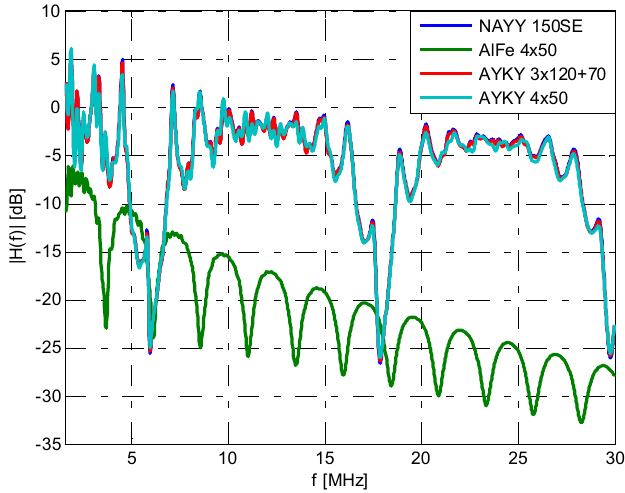
Figure 10. Throughout for different types of cables. Table 2. Possibility of communication—without repeaters.